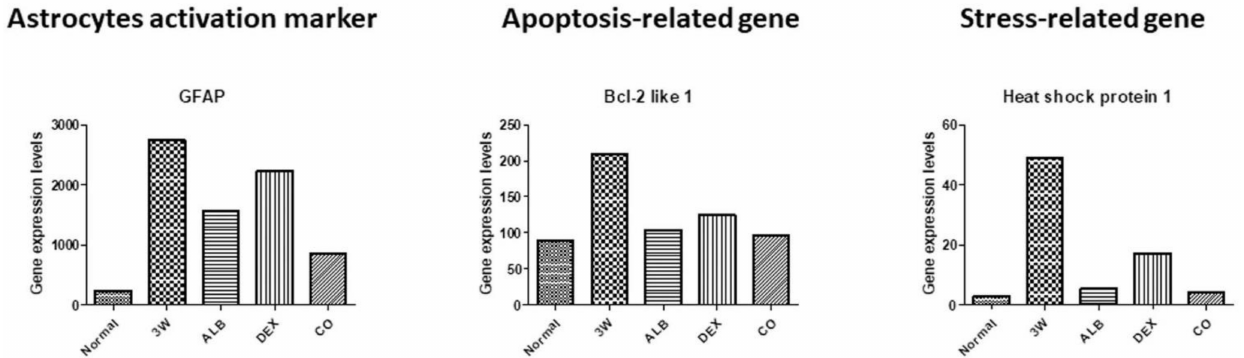
Figure 12. RNA-seq data of astrocytes activation marker, apoptosis-related gene, and stress-related genes after treat- ment of albendazole alone dexamethasone alone, and co-therapy of the two drugs to BALB/c mice infected with Angiostrongylus cantonensis